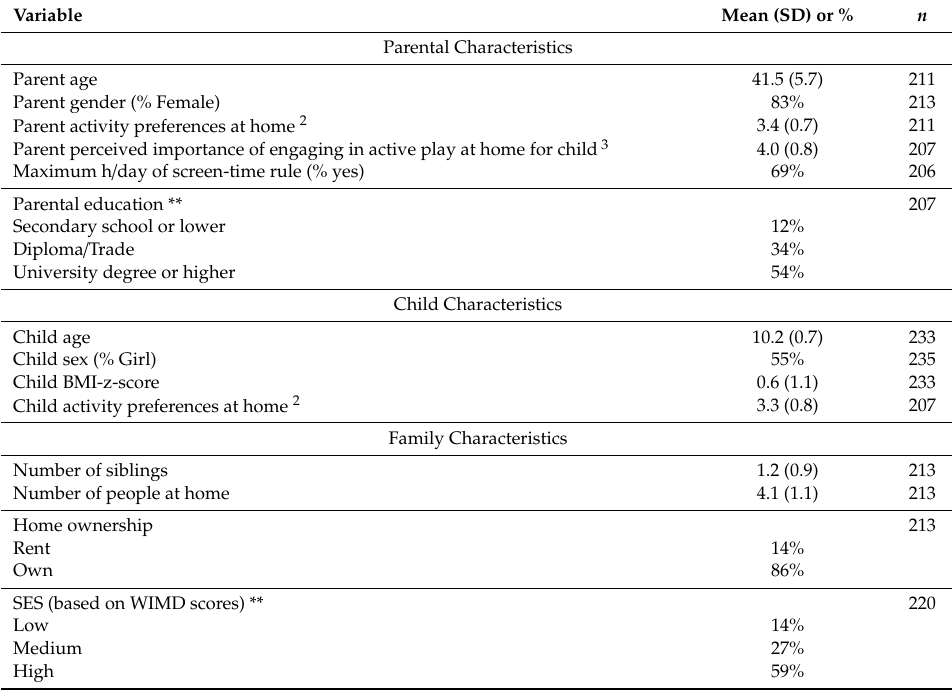
Table 1. Participant characteristics and descriptive